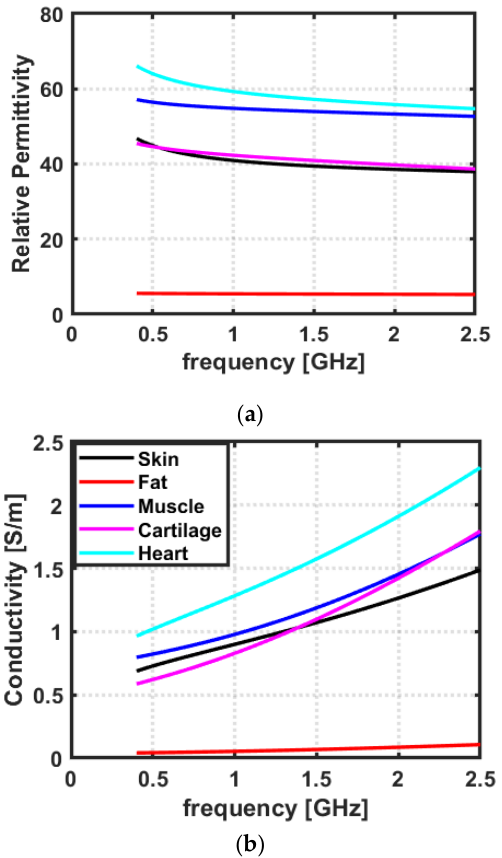
Figure 7. The ( a ) relative permittivity and ( b ) conductivity of the considered tissues as a function of frequency. The values are taken from Gabriel et al. [33].